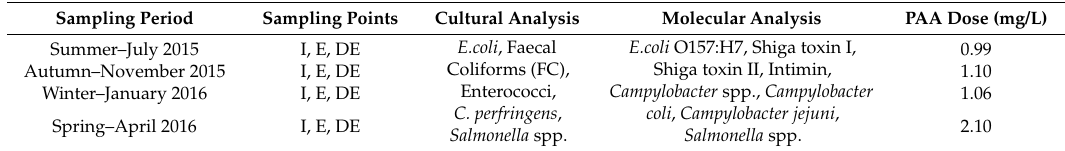
Table 2. Overview of study